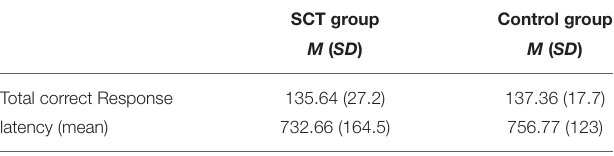
TABLE 5 | Mean and standard deviation of the AST measures in the SCT and control groups.